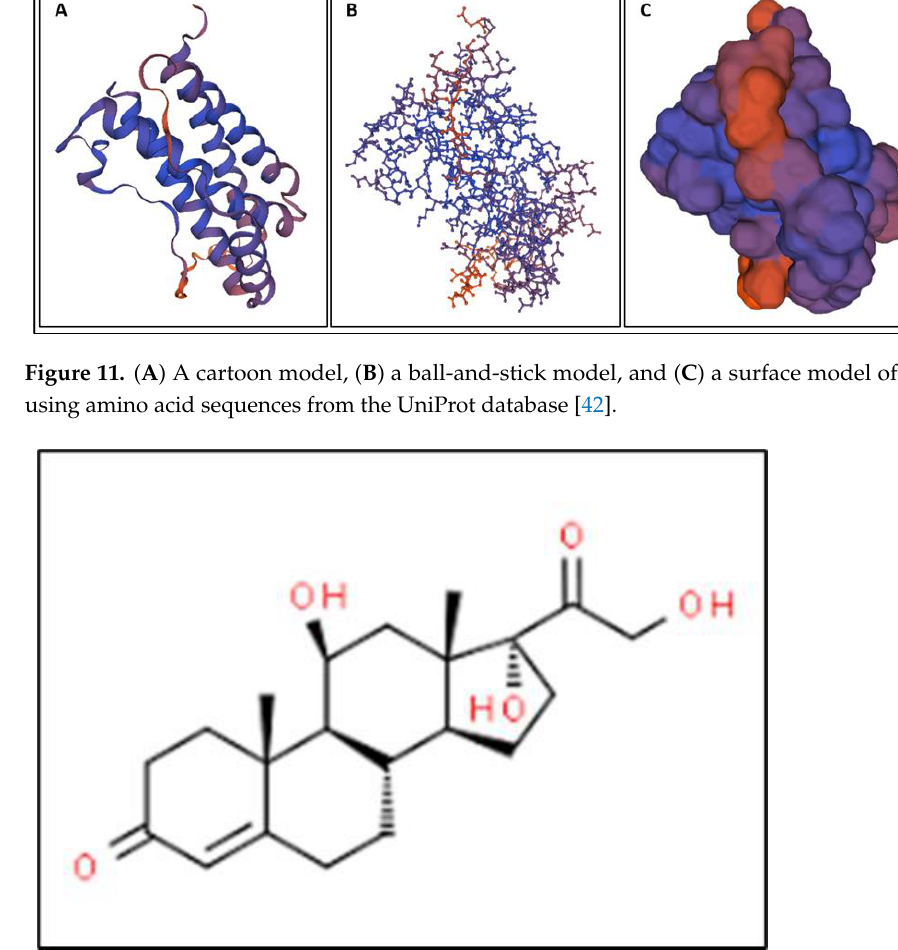
Figure 12. The chemical structure of cortisol [43].